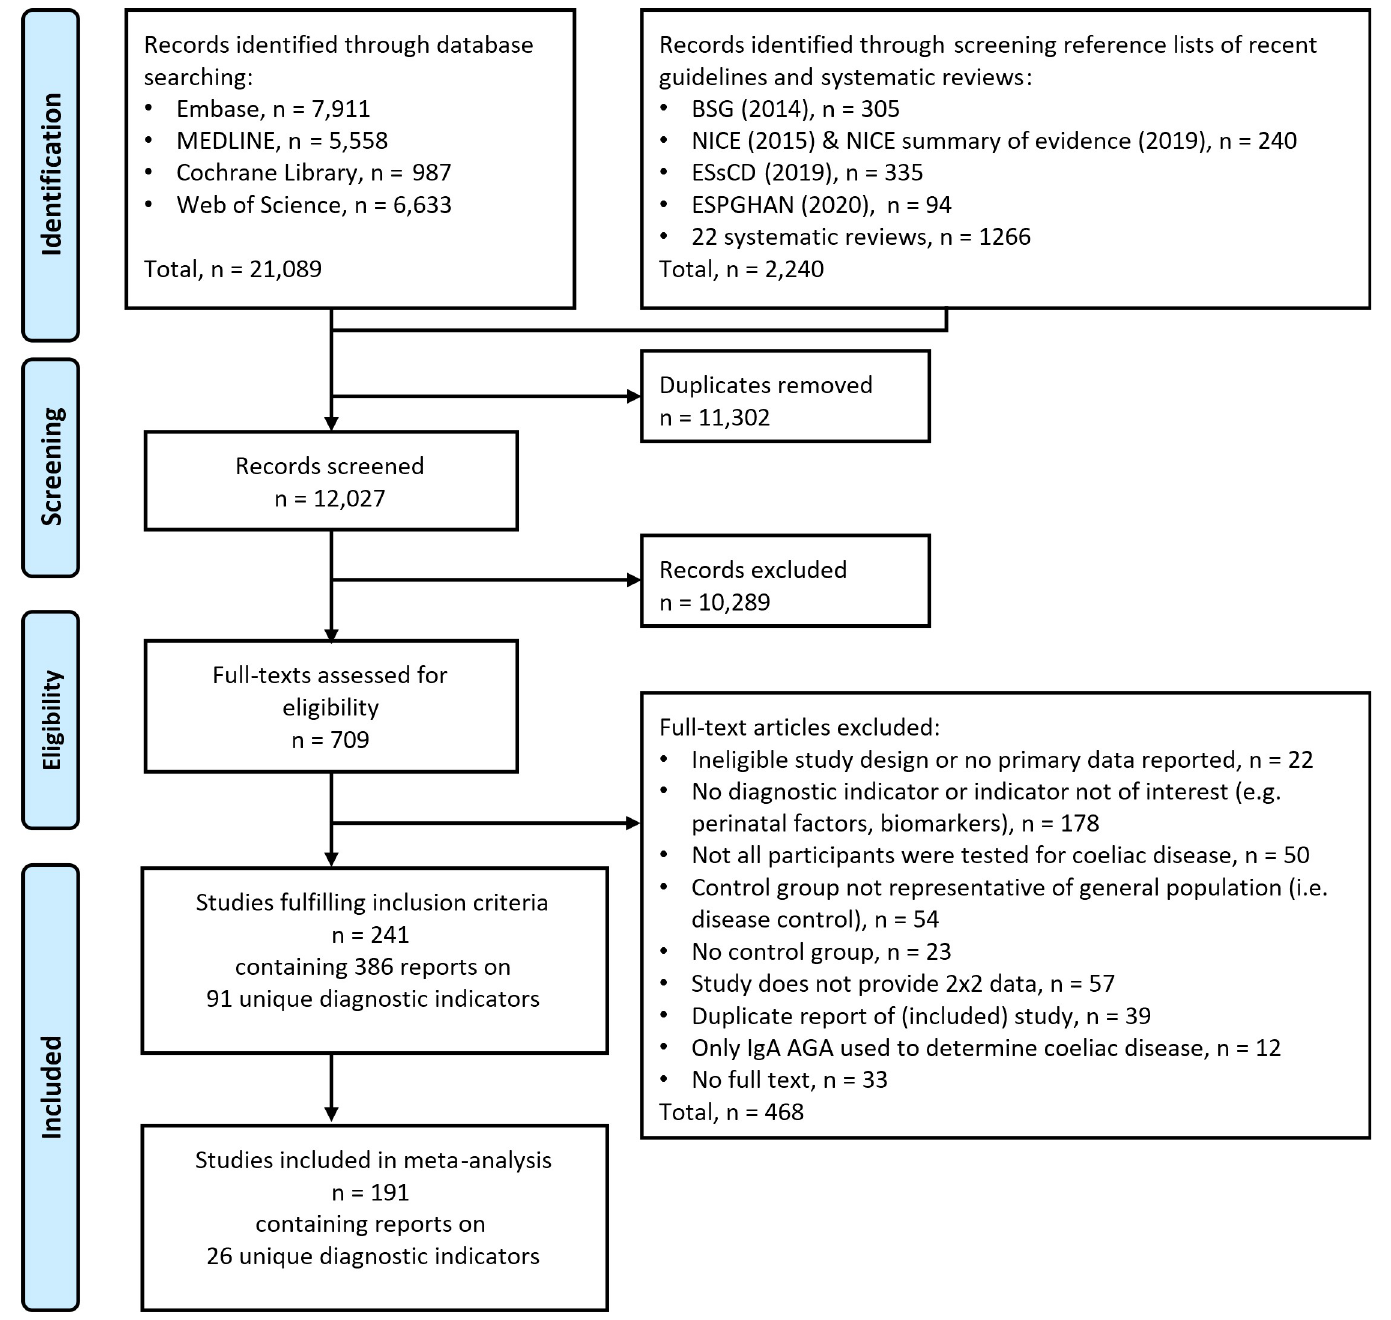
Fig 1. PRISMA flow diagram. Abbreviations: BSG: Guidelines from the British Society of Gastroenterology [9]; NICE: National Institute for Health and Care Excellence; ESsCD: European Society for the Study of Coeliac Disease guideline [8]; ESPGHAN: European Society Paediatric Gastroenterology, Hepatology and Nutrition Guidelines